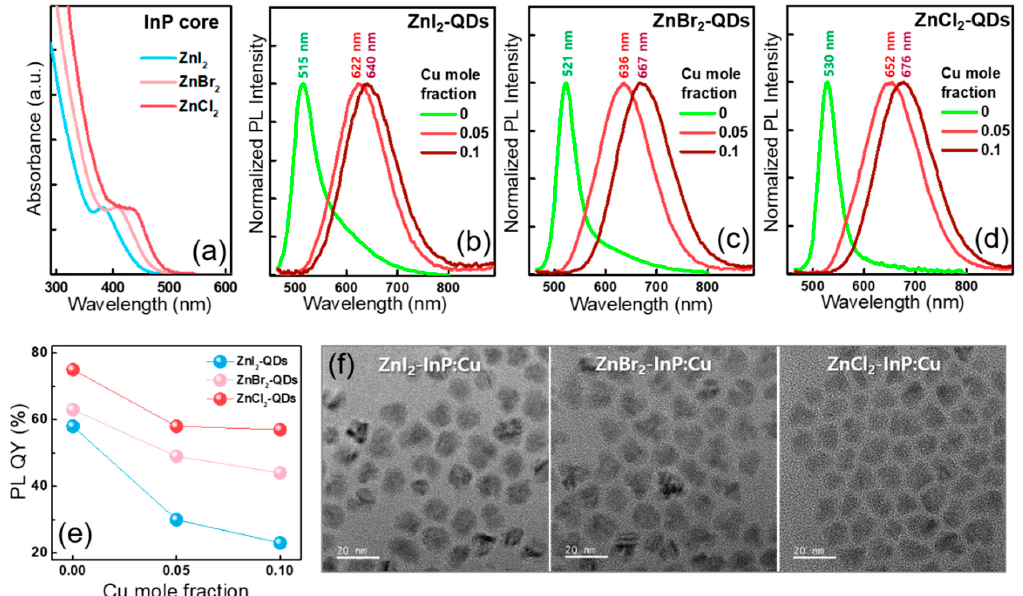
Figure 3. ( a ) Absorption spectra of InP cores synthesized with different Zn halide precursors of ZnI 2 , ZnBr 2 , and ZnCl 2 . The normalized PL spectra of undoped and Cu-doped QDs with 0.05 and 0.1 mole fraction based on InP cores synthesized with ( b ) ZnI 2 ; ( c ) ZnBr 2 ; and ( d ) ZnCl 2 ; ( e ) The variations of PL QYs of a series of samples in ( b – d ); ( f ) TEM images of Cu-doped InP/ZnSe/ZnS QDs synthesized with ZnI 2 , ZnBr 2 , and ZnCl 2 with the same Cu concentration of 0.05 mole fraction. The scale bars are 20 nm for all.